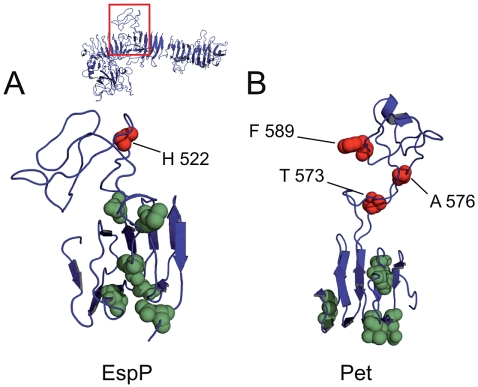
Transport activity of insertions in the central part of the passenger domain.A. Linker inserts surrounding Domain 2 in EspP are depicted as coloured spheres. Transport active constructs are illustrated in green, secretion-incompetent mutants are marked red. Insert H522 in the loop of Domain 2 leads to loss of autotransport activity, whereas neighbouring inserts in the β-helical stem do not influence secretion competence. B. Display of mutagenesis results from Dutta et al. (2003) on our Pet model. Insertions in the respective Domain 2 lead to loss of transport functionality, while insertions in the β-helix core are permissive to transport activity. Localisation of Domain 2 within the passenger domain structure is exemplified for EspP.